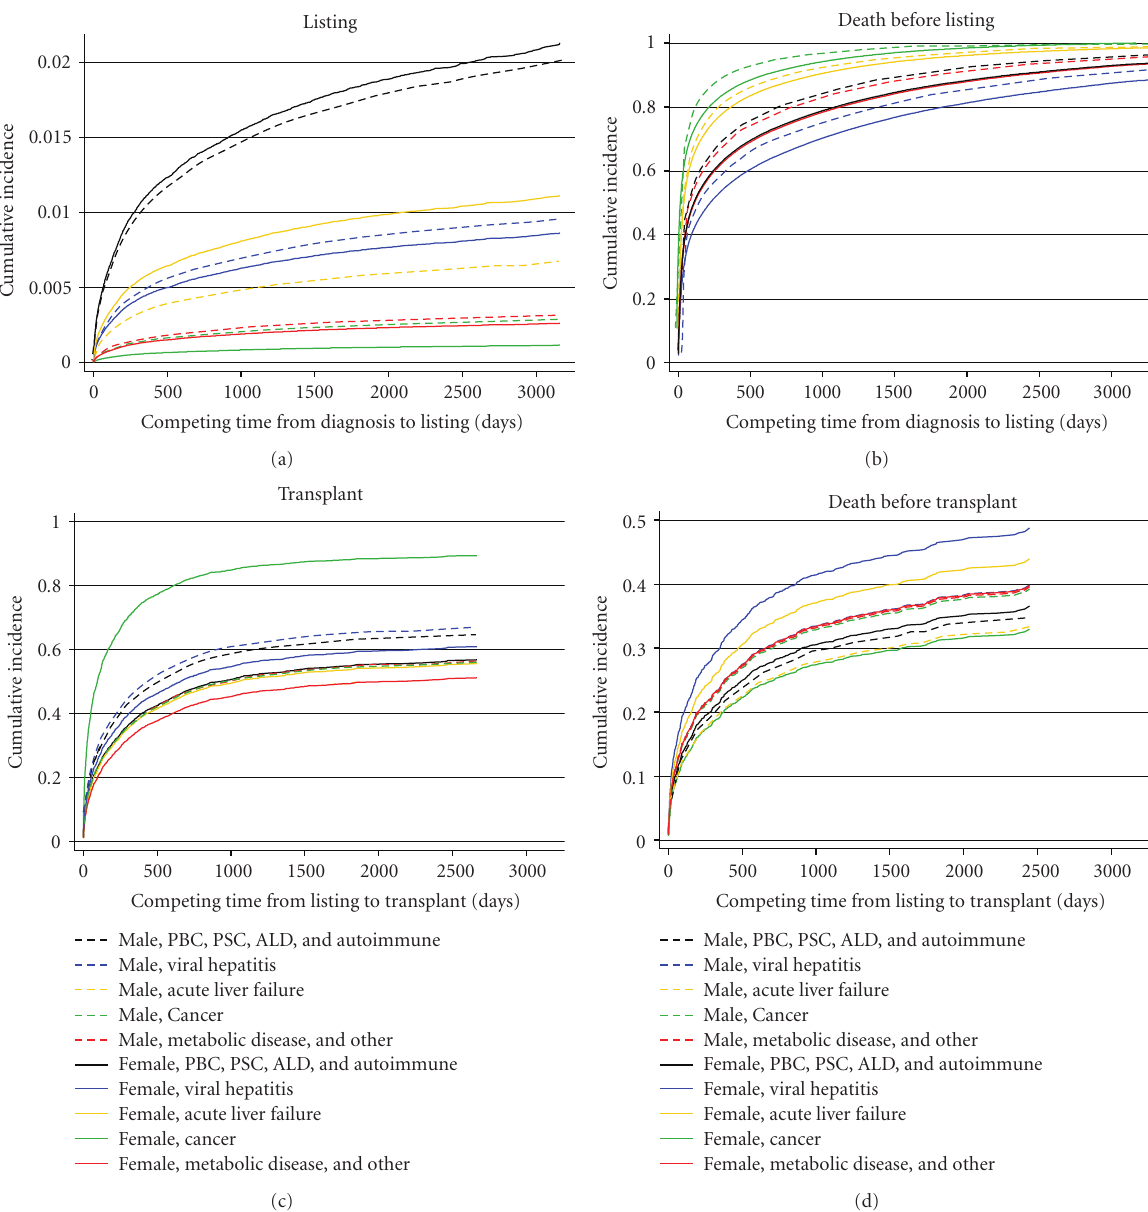
Figure 4: Gender-related results in the adjusted competing risks model. Abbreviations: PBC-primary biliary cirrhosis; PSC-primary sclerosing cholangitis; ALD-alcoholic liver